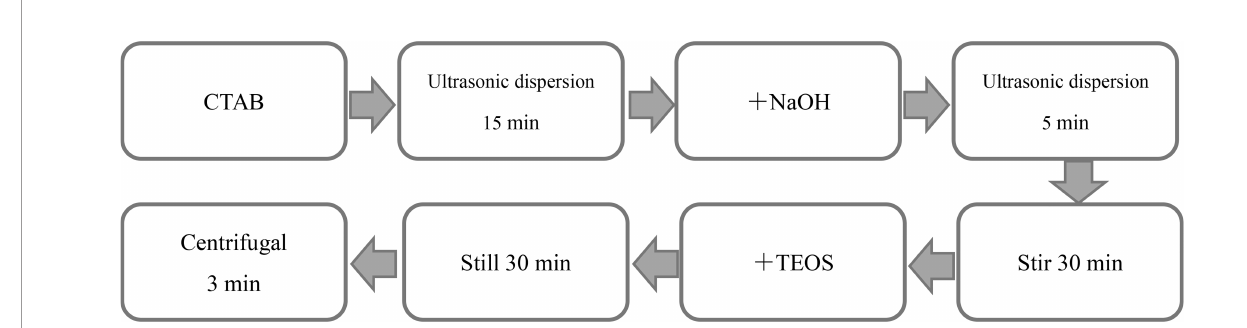
FIGURE 1 | Flow chart of preparation of mesoporous